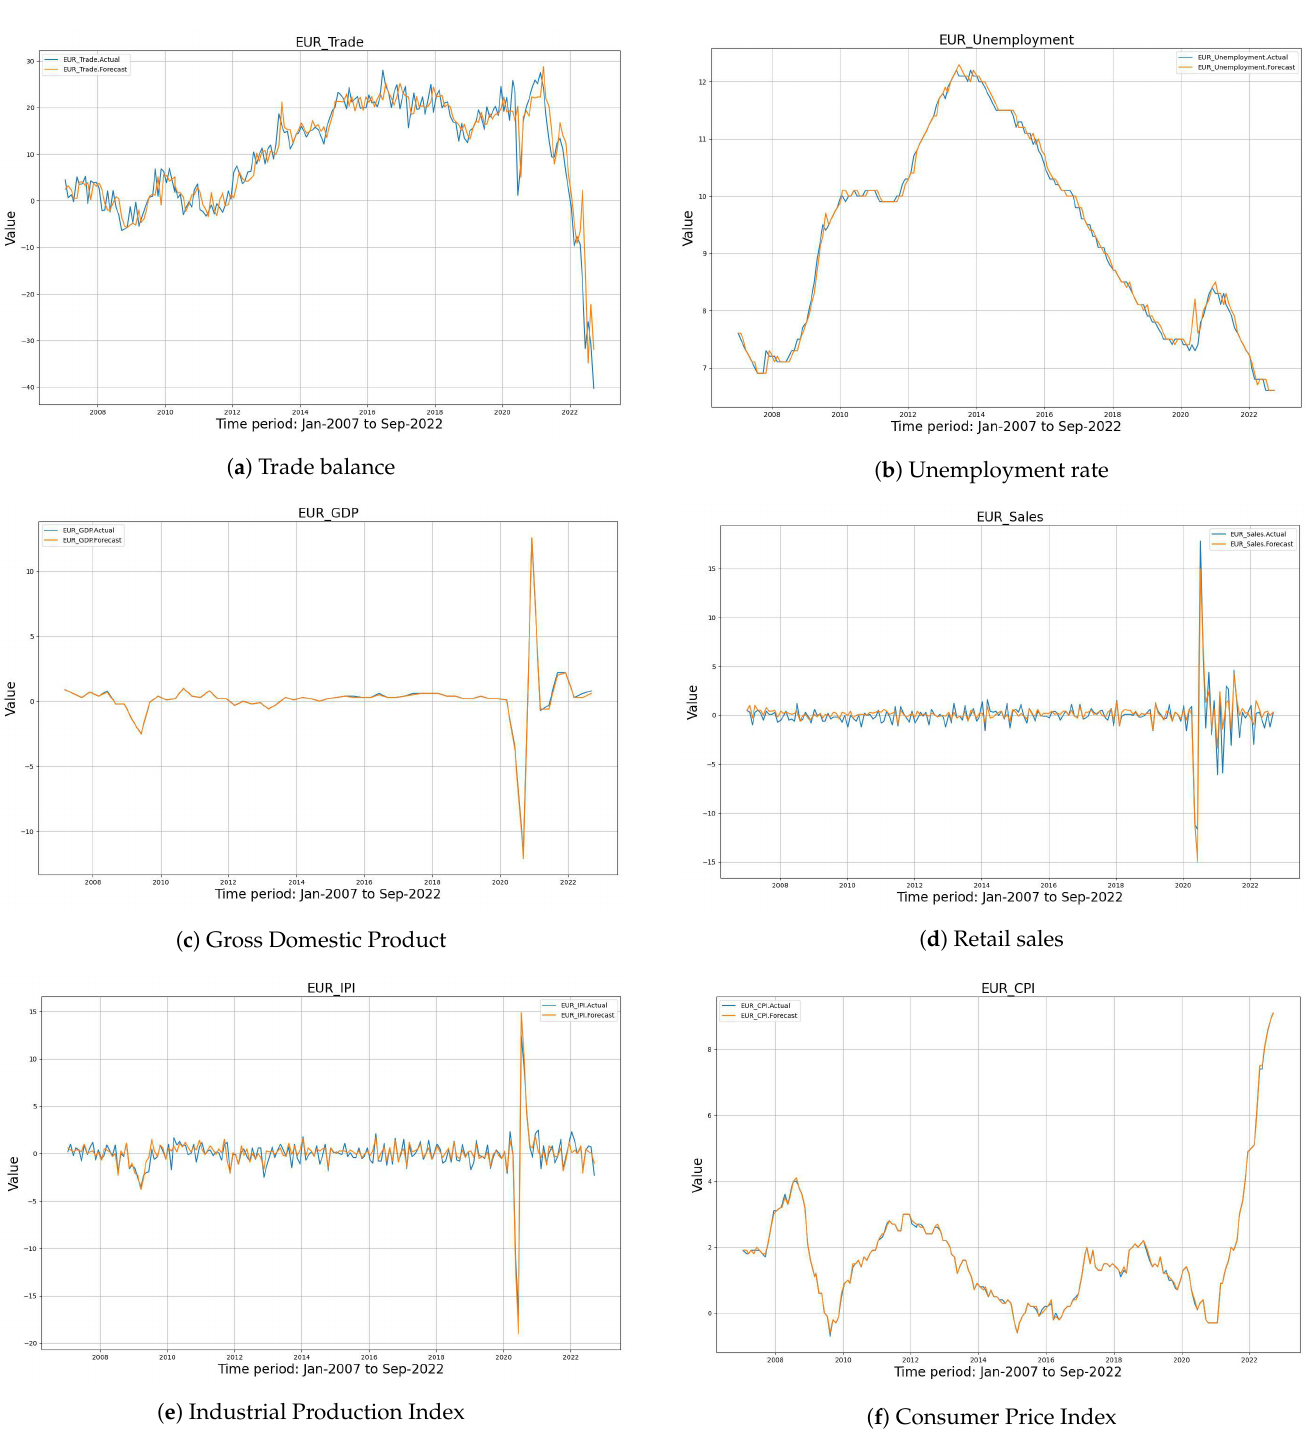
Figure 2. Plot showing the time evolution of the 6 macroeconomic news items from Europe (EUR) for the time period analysed between June 2007 and September 2022. The current value of each time period is marked in blue, and the predicted value in